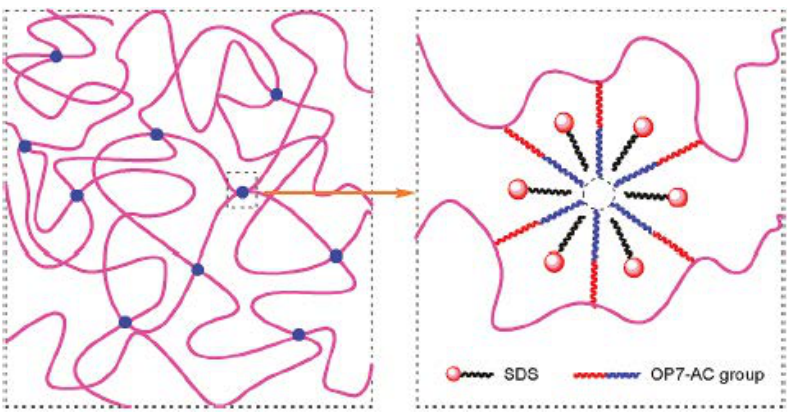
Figure 8. Micellular crosslinks of OP7-AC and SDS